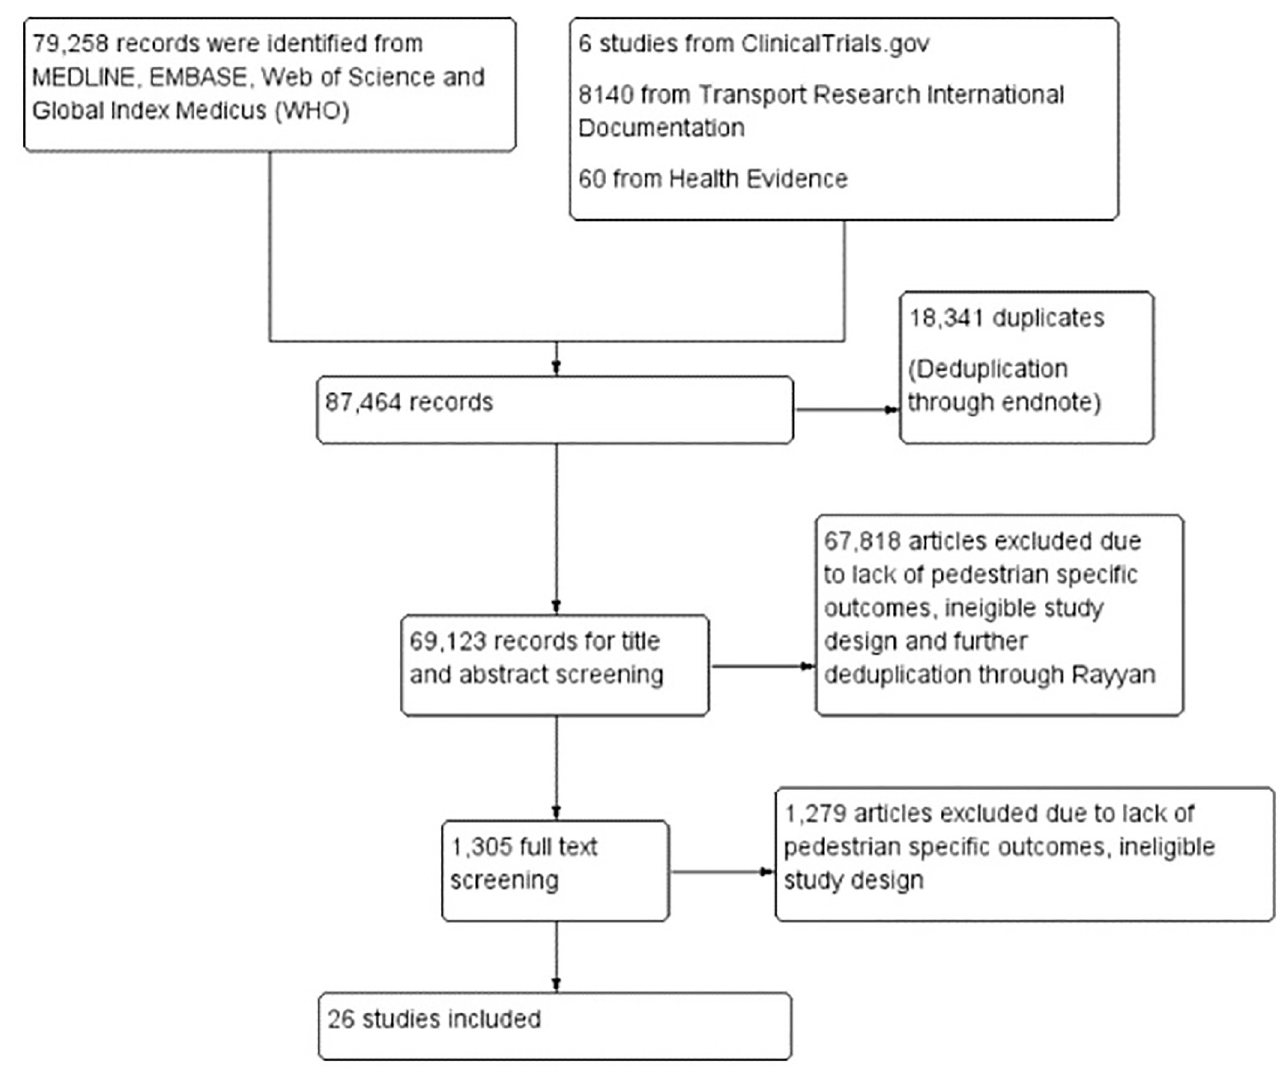
Fig 1. Flowchart summarizing the search and study selection